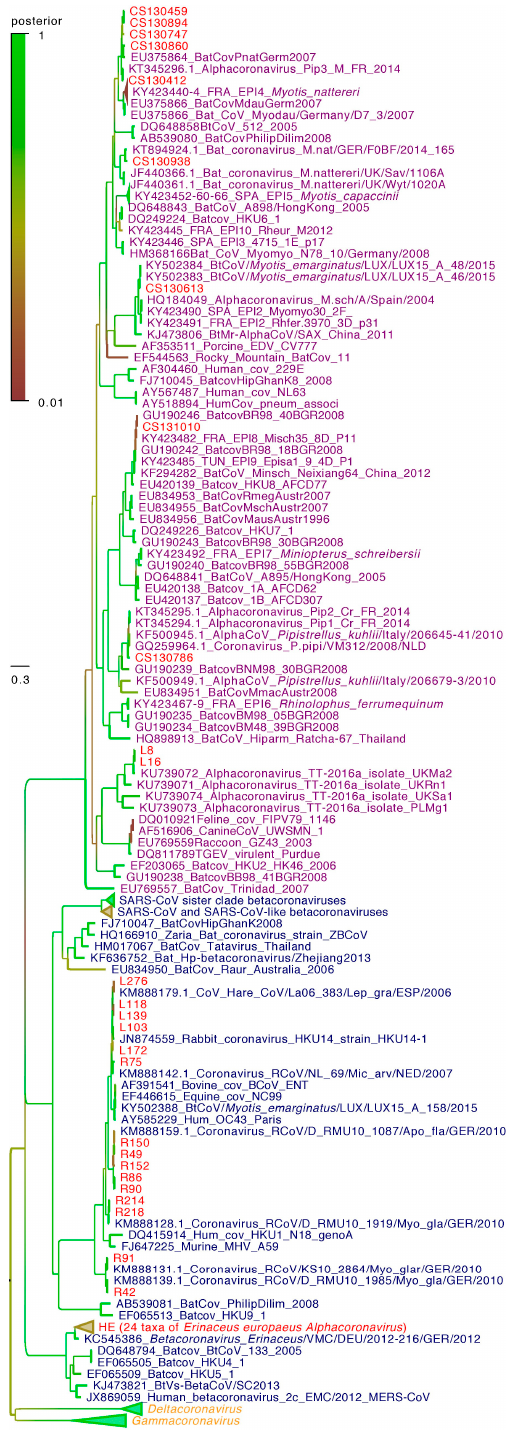
Figure 2. Bayesian phylogeny of 50 genetic sequences of viruses detected in the study with 127 representative sequences of the whole diversity of the group of Coronavirinae . Selected coronavirus RdRp sequences, including some extracted from full genomes, were aligned with original sequences from this study in SEAVIEW v4.6. [8]. Statistical support (posterior probability) of nodes are depicted using a gradual color code of the tree, with green indicating significant posterior probability values (>0.95). Genbank identification numbers, strain names, and the main information are written in taxa labels. Taxa labels of Alphacoronavirus , Betacoronavirus and of the clade grouping Gammacoronavirus and Deltacoronavirus are in purple, blue, and orange, respectively. Viruses detected in this study are depicted in red (HE: Sequences from hedgehogs, R: Sequences from rodents, CS: Sequences from bats; and L: Sequences from rabbits).